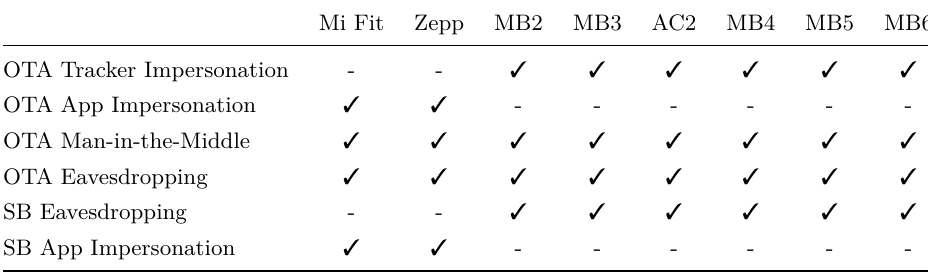
Table 4: Evaluation results for OTA and SB attacks. The first column shows the attack name, the following eight columns contain the targets (two companion apps and six fitness trackers). A checkmark ( (cid:51) ) means that the attack was successful, and a hyphen (-) means that the attack does not apply to that target. MB and AC abbreviate Mi Band and Amazfit Cor. The SB attacks on the Mi Fit and Zepp apps were successfully tested on six Android versions (see Table